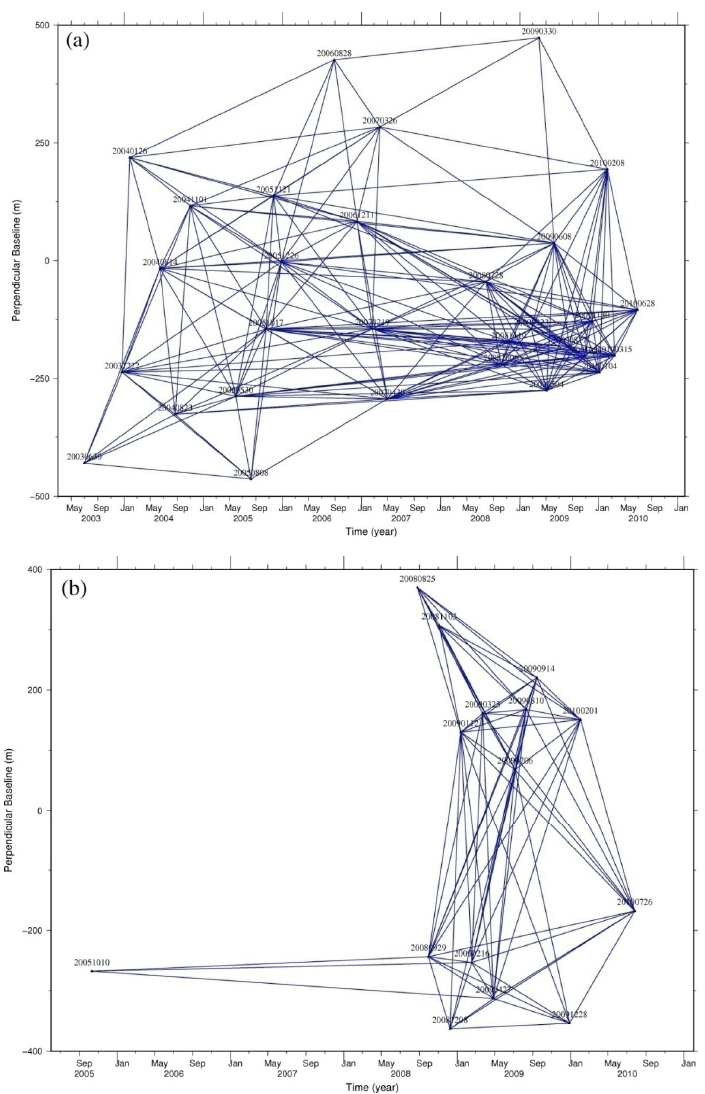
Figure 2. Temporal and spatial baseline of InSAR interferograms: ( a ) D391 and ( b ) A298. During SAR data processing, we multilooked the SAR images 4 and 20 times in the azimuth and range directions, respectively, during processing to improve the signal-to-noise ratio. The phase component of the topography was removed using the three-arc second shuttle radar topography